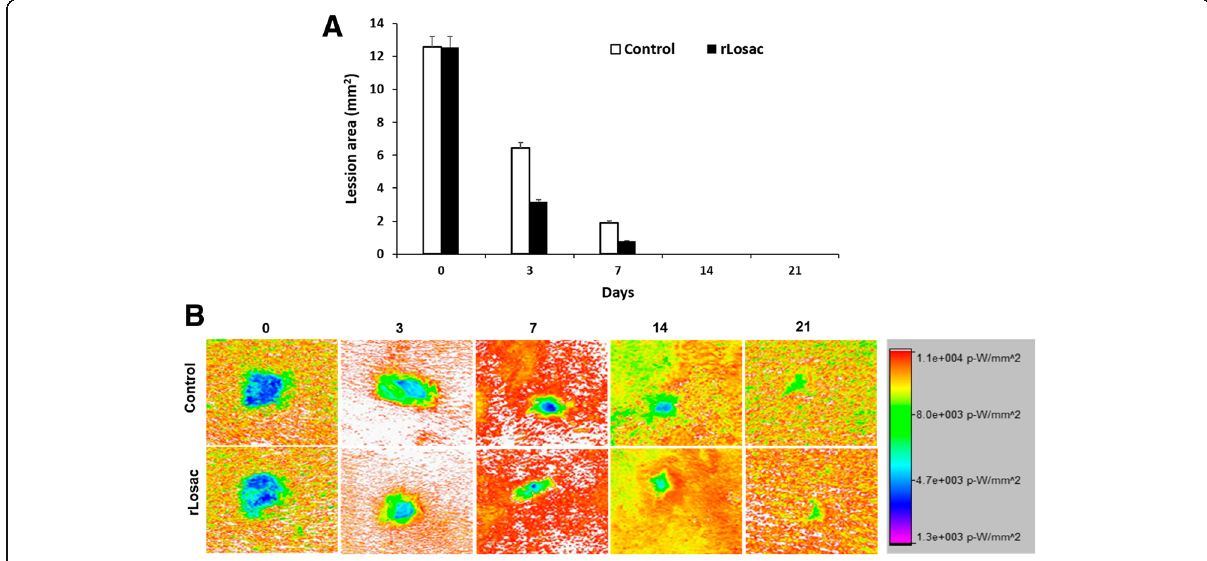
Fig. 2 a Graph of the optical density of skin lesions on the day of induction, and at 3, 7, 14 and 21 days after surgery. b Images were collected for natural fluorescence detection of lesions. The optical density (photons/s/mm 2 ) from a fixed region of interest (ROI) was